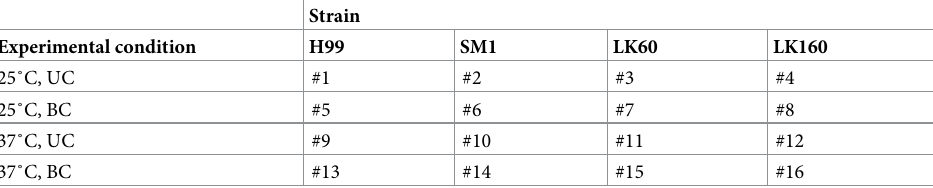
Table 2. Samples to be collected for the subsequent MS analysis. Each sample will be collected in